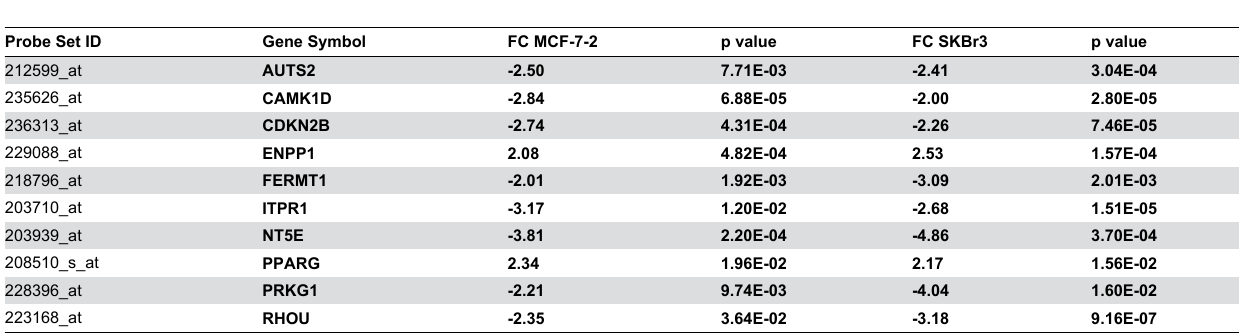
Microarray data generated as described in the text. Full results can be found in table